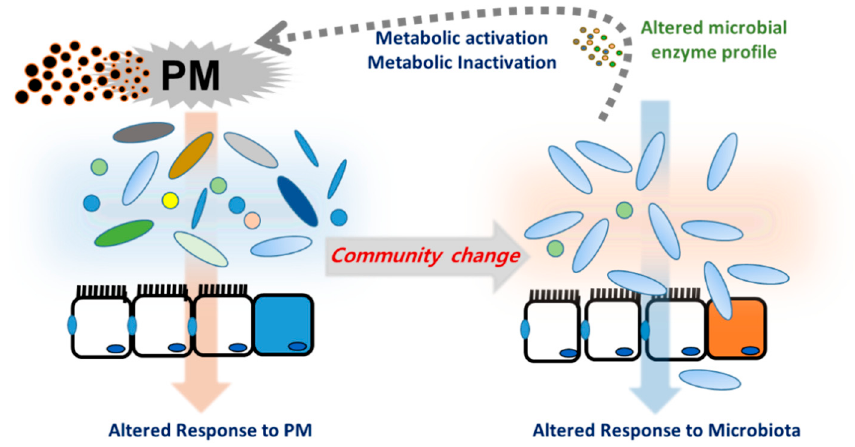
Figure 2. Particulate matter (PM)-induced alternation of mucosal microbial community. Host- and microbiota-derived xenobiotic metabolic enzymes are involved in metabolism of PM constituents. Moreover, PM can directly alter the microbial community, which inversely determines the fate of PM-derived xenobiotics or affect host responses during PM exposure.